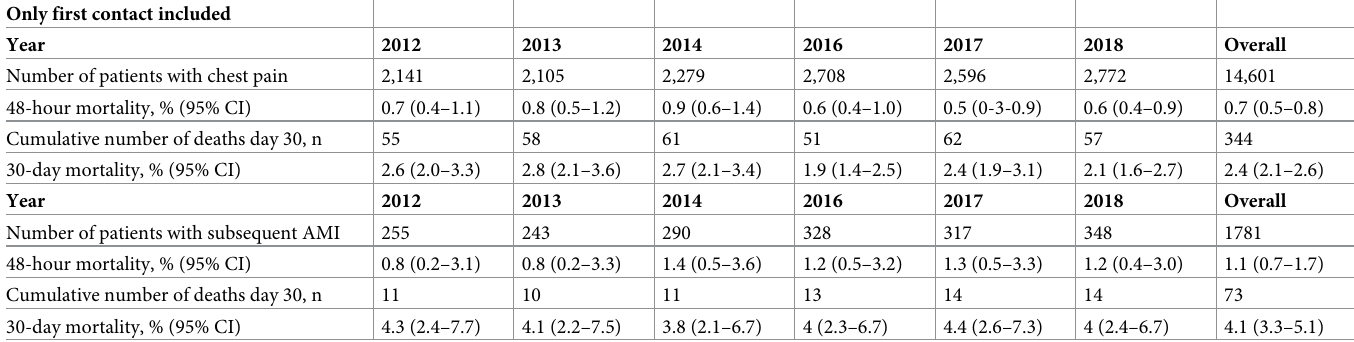
Table 4. Cumulative deaths and mortality estimates for patients with chest pain, and those with a subsequent AMI diagnosis. Note for patients with more than one ambulance contact in the study periods, only the first contact was used. Cumulative number of deaths within 48-hours omitted due to microdata. AMI, acute myocardial